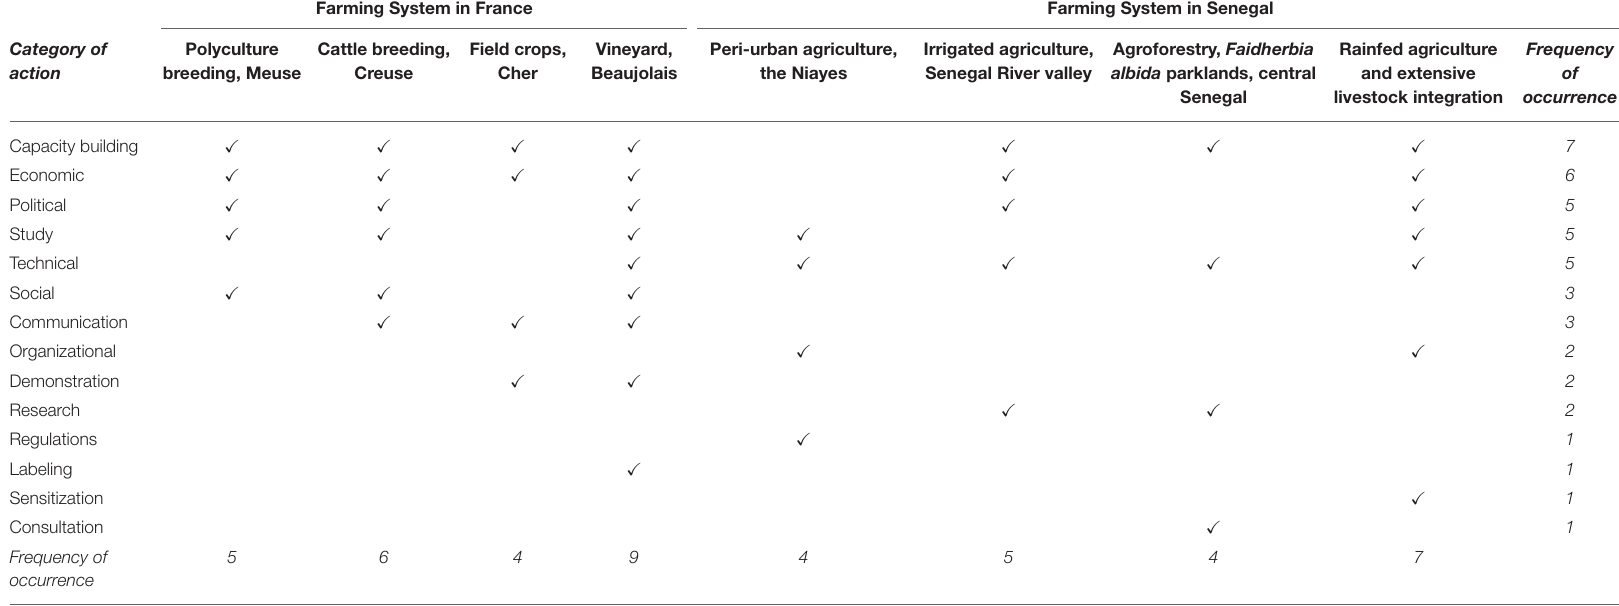
TABLE 3 | Categories of potential actions proposed by stakeholders to boost soil carbon sequestration in eight different farming systems in France and